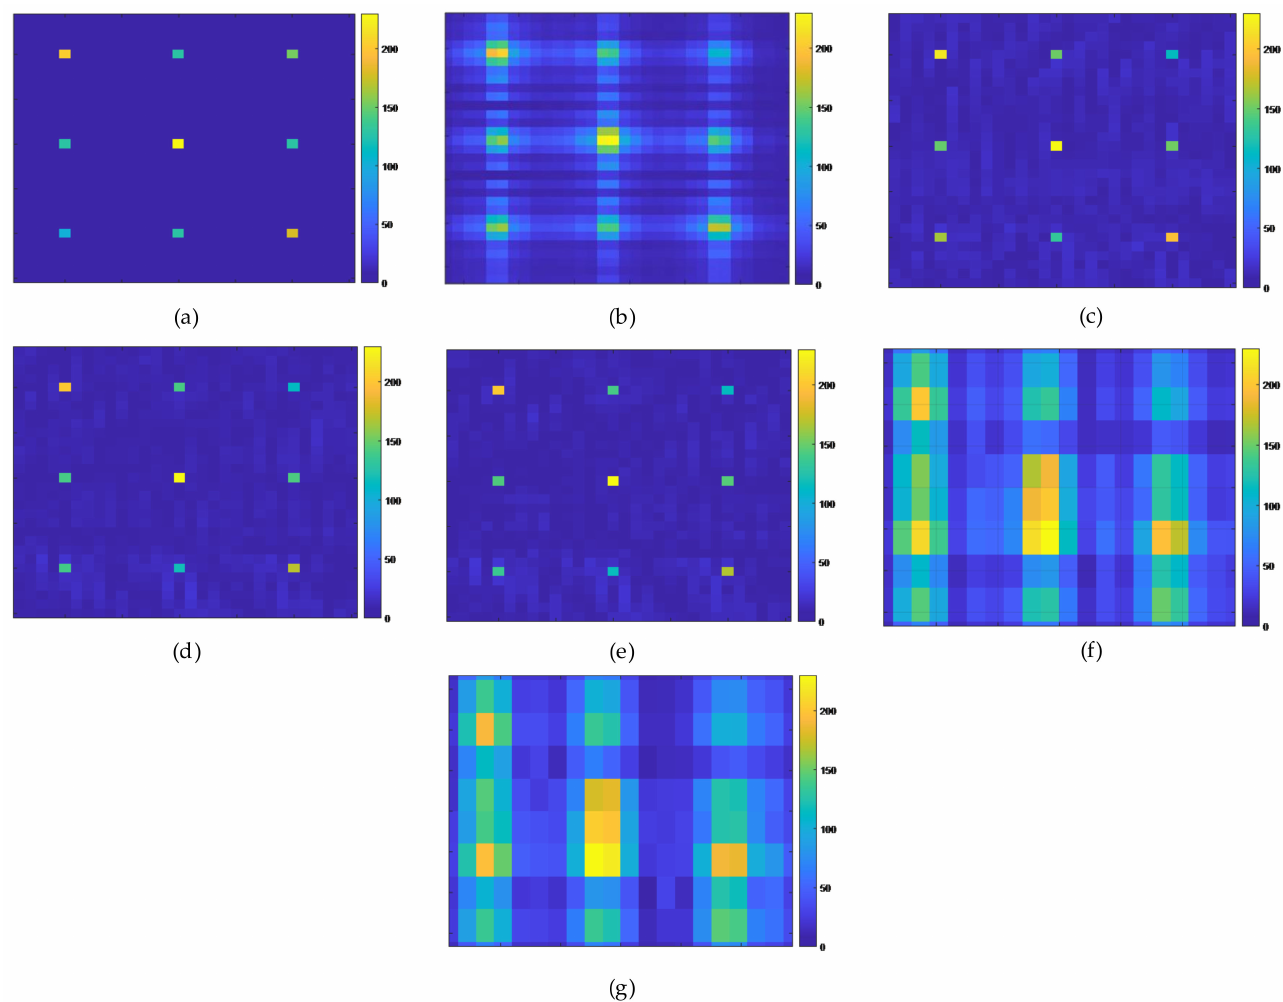
Figure 3. Point target imaging results. ( a ) is original point target, ( b ) is Range Doppler method, ( c ) is our proposed method with L = 3, ( d ) is our proposed method with L = 8, ( e ) is our proposed method with L = 11, ( f ) is ISTA method and ( g ) is Fast ISTA